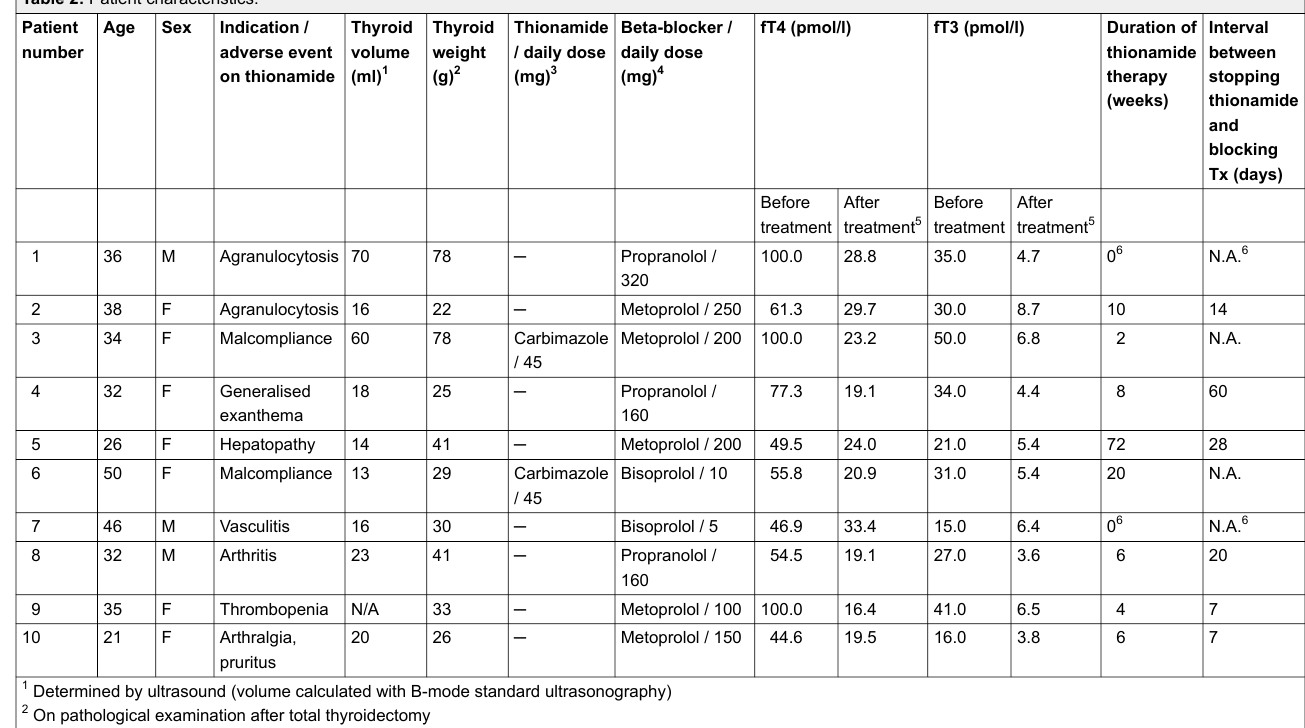
Table 2: Patient characteristics. Patient number